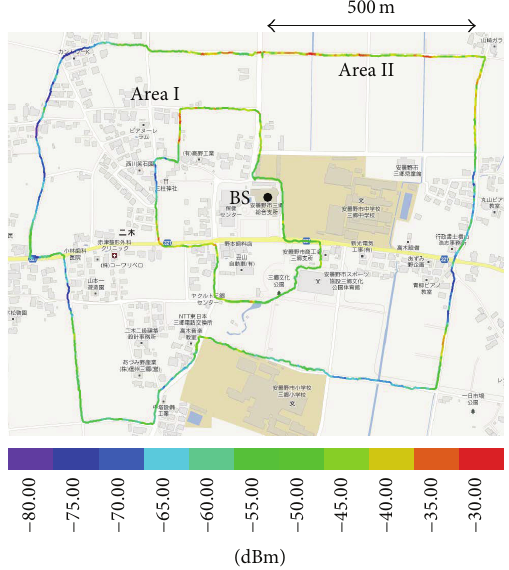
Figure 7: Route map and received power at each